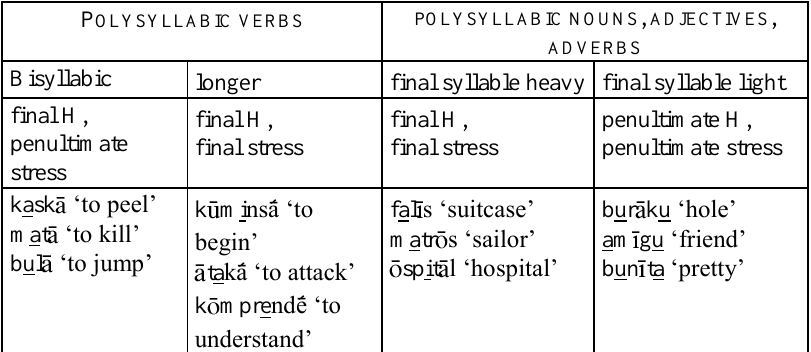
Table 1. Regular tone and stress placement (after Kouwenberg & Murray,